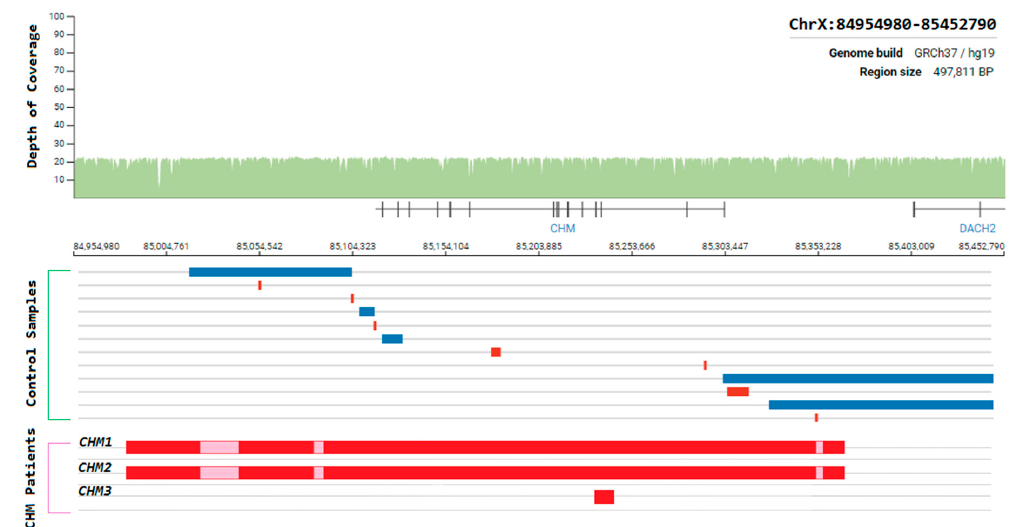
Figure 11. Schematic representation of the genomic region surrounding the CHM gene. Whole-genome coverage data from a control population database (https://gnomad.broadinstitute.org/). Structural variants detected from controls samples and Target 5000 patients are aligned to this region to illustrate the instability of this genomic region. Blue = duplication, Red = deletion, Pink = template positive results likely due to highly similar sequence elsewhere in the genome.